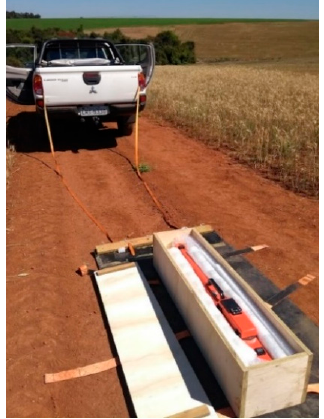
Figure 2. Mobile data acquisition structure for EM38-MK2 on-the-go survey.